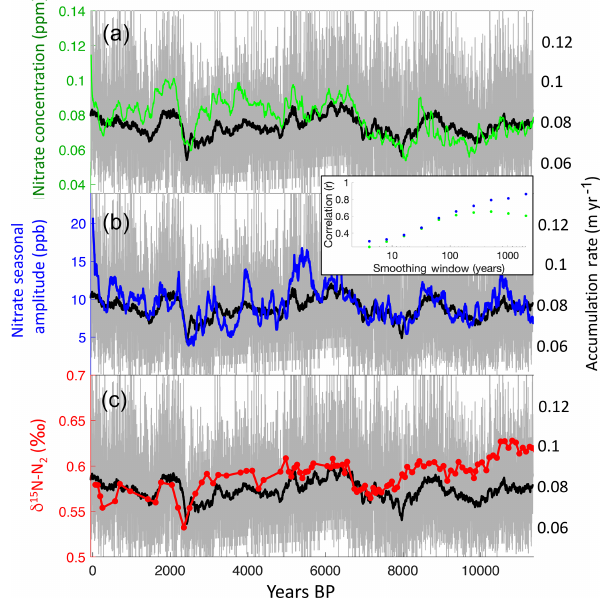
Figure 11. The Holocene accumulation rate at the South Pole com- pared with nitrate and δ 15 N–N 2 . In each panel, annual accumu- lation rates are depicted in gray, with the running 100-year mean shown in black. These results are compared with 100-year median annual values of nitrate concentration (a) and seasonal amplitude in nitrate concentration (b) as well as δ 15 N–N 2 values (c) . All three metrics exhibit shared variability on multicentennial to millennial timescales. The inset shows the correlation between accumulation rate and nitrate concentration (green) (a) and between accumula- tion rate and nitrate seasonal amplitude (blue) (b) against the length of the smoothing window, with both exhibiting high correlations, especially at lower